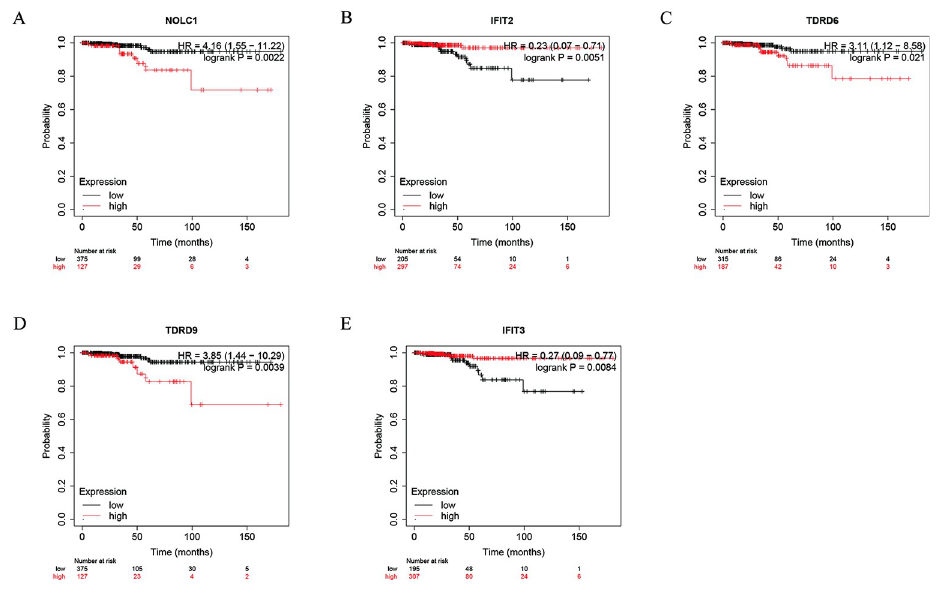
Fig 3. The Kaplan-Meier plotter analysis. (A) NOLC1; (B) IFIT2; (C) TDRD6; (D) TDRD9; (E) IFIT3. THCA patients (Fig 5B and 5C) with a harmonious consistency (C-index = 0.67) between the predicted and observed survival.